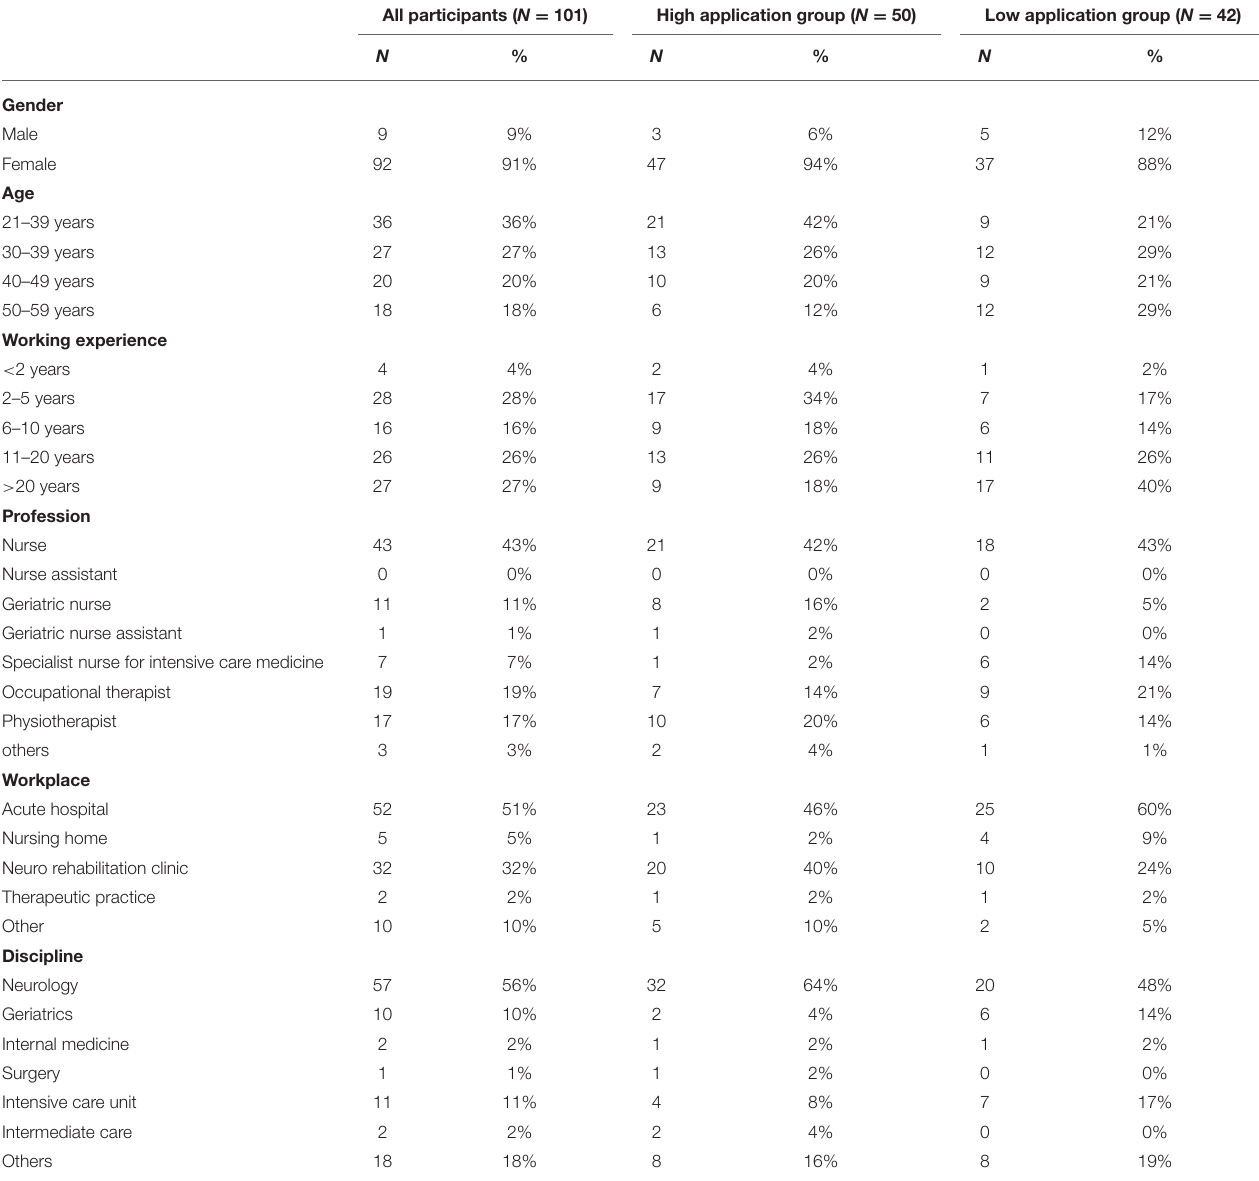
TABLE 2 | Demographics of the participants. All participants ( N = 101) High application group ( N =